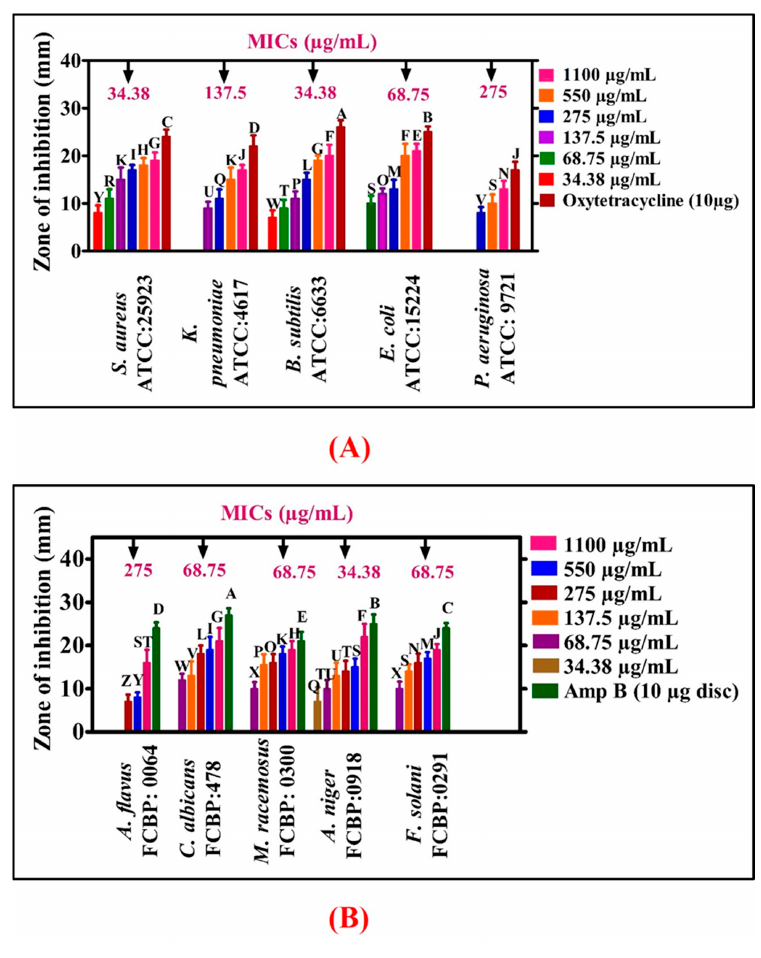
Figure 7. ( A ) Various antimicrobial activities of RT mediated NiONPs. Data represents the mean of three replicates and each alphabet indicates significance at p < 0.05 ( A ) MICs values of RT-NiONPs against various pathogenic bacterial strains ( B ) Antifungal potencies of RT-NiONPs against different fungal strains.